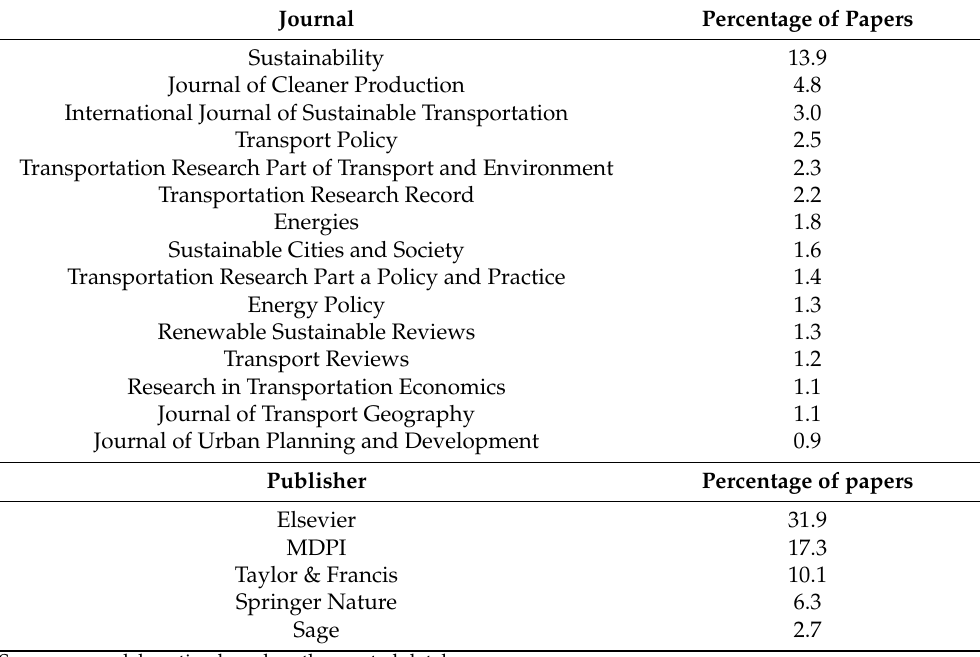
Table 4. Scientific journals and publishers with the largest number of publications in sustainable